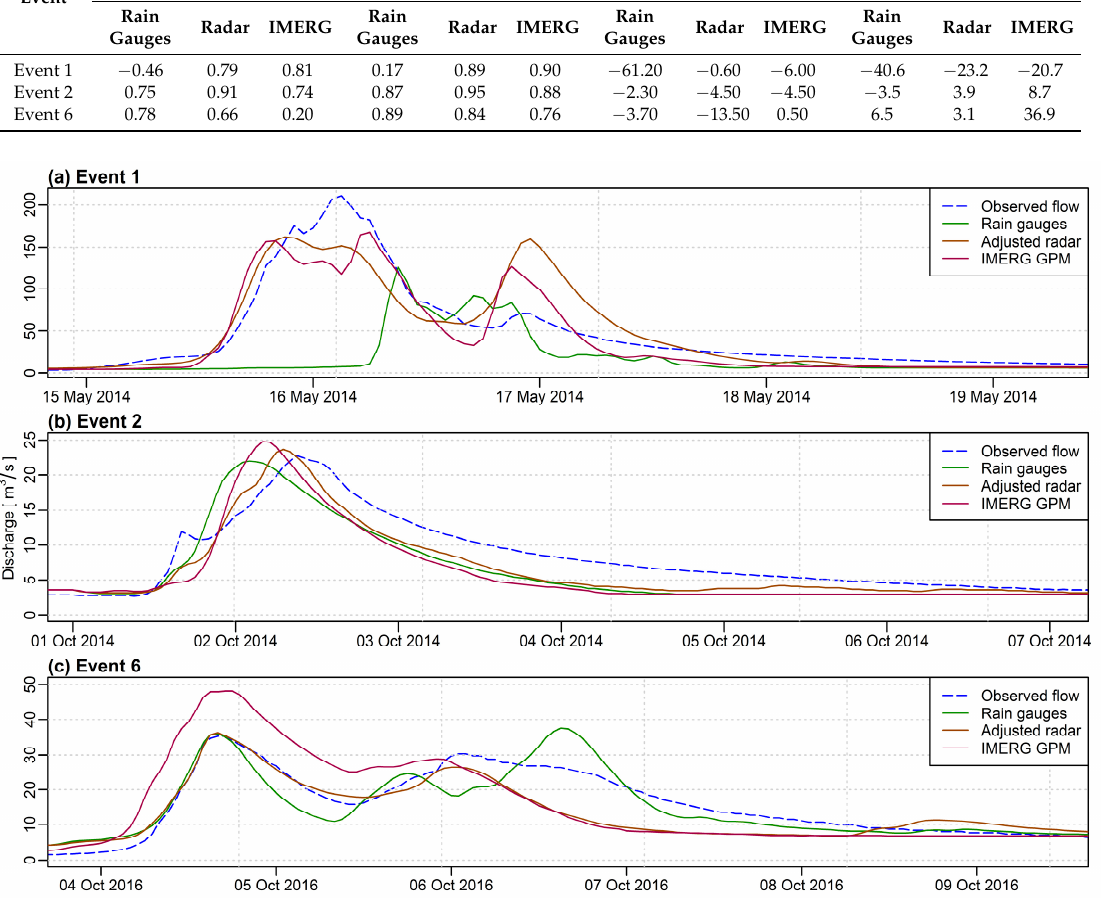
Figure 6. Comparison of simulated and observed hydrographs for the calibration events ( a ) Event 1: 14–23 May 2014, ( b ) Event 2: 3–7 October 2014, ( c ) Event 6: 3–9 October